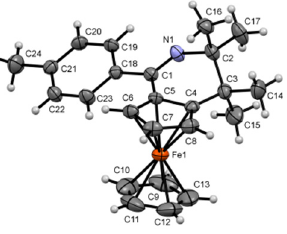
Figure 1. Molecular structure of 3a according to XRD data in the thermal ellipsoids of the 50% probability level (only the ( R p )-enantiomer is shown).